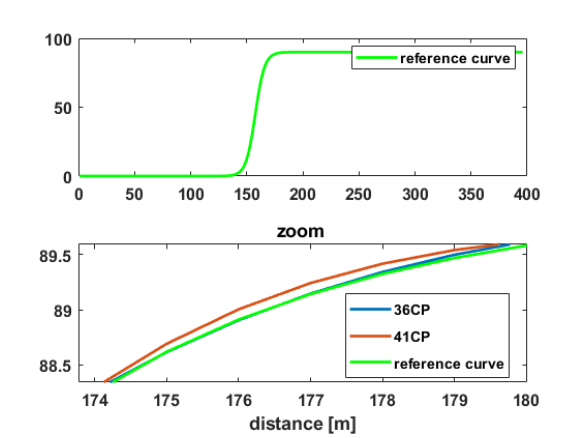
Fig. 4. (top) reference curve corresponding to a challenging case; (bottom) zoom for 2 approximations corresponding to 36 CP (blue), 41 CP